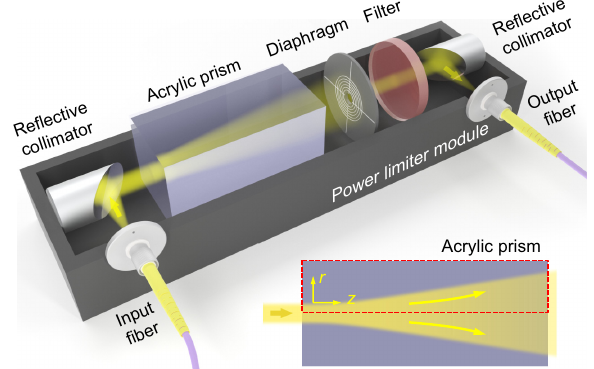
FIG. 1. Schematic of the power limiter design. An acrylic prism is used as the active medium. When the absorbed energy introduces temperature gradients inside the prism, the input collimated Gaussian beam diverges due to the thermo-optical defocusing effect. A diaphragm is placed after the prism to con- trol the collectible optical power. The optical filter restricts the working wavelength range for security analysis. The inset is the top view of the acrylic prism and the diverged Gaussian